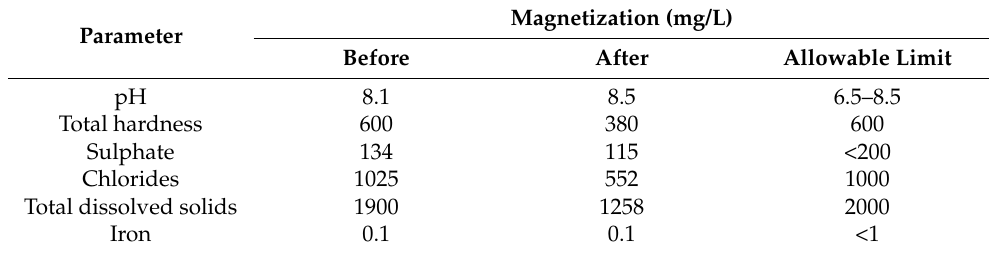
Table 4. Values of water quality parameters of normal water and magnetized